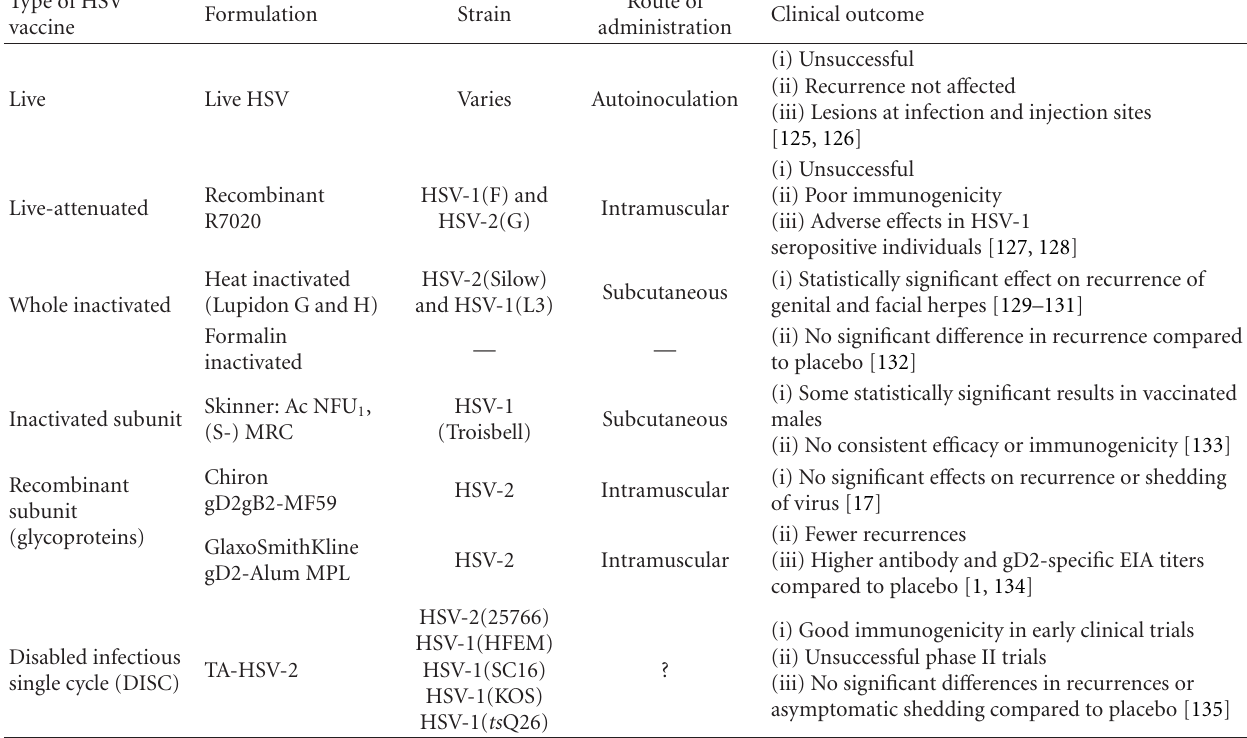
Table 2: Herpes vaccine formulas used in clinical